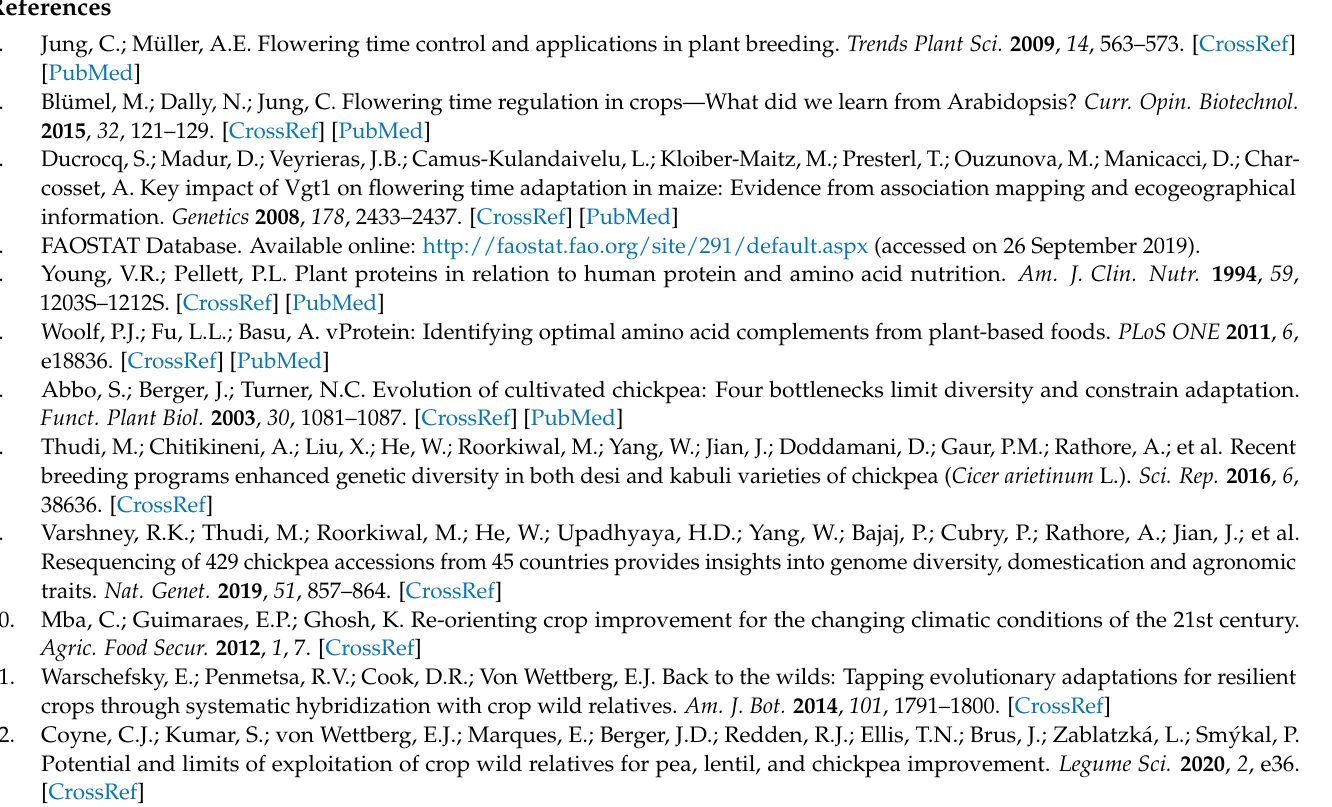
Chickpea markers. Summary genetic marker information. Explanation of table columns: “Marker” gives SNP marker names; “Chrom” gives chromosome location; “Position” gives M base pair position on the reference chickpea genome; “Refallele” is the reference base; “Altallele” is the alternative base; “Sequence” is the unique sequence surrounding the SNP (the SNP itself is indicated in square brackets within the sequence). Supplementary Data S3: Chickpea map phenotypes and genotypes. Genotype and phenotype information for two chickpea mapping families. Explanation of table columns: “Fieldid” gives sample names used in the field experiments; “DFFmod” is corrected days to first flowering; “FC” is flower color (coded as white cultivar-like = 1, purple wild-like = 3, and mixed colors = 2); “Genoid” are sample names for genotyping (names starting with 1 belong to the Gokce × Oyala-084 mapping family and names starting with 2 belong to the Gokce × Karab-092 family); subsequent columns list genotypes for each SNP listed in map order. In the genotype rows;